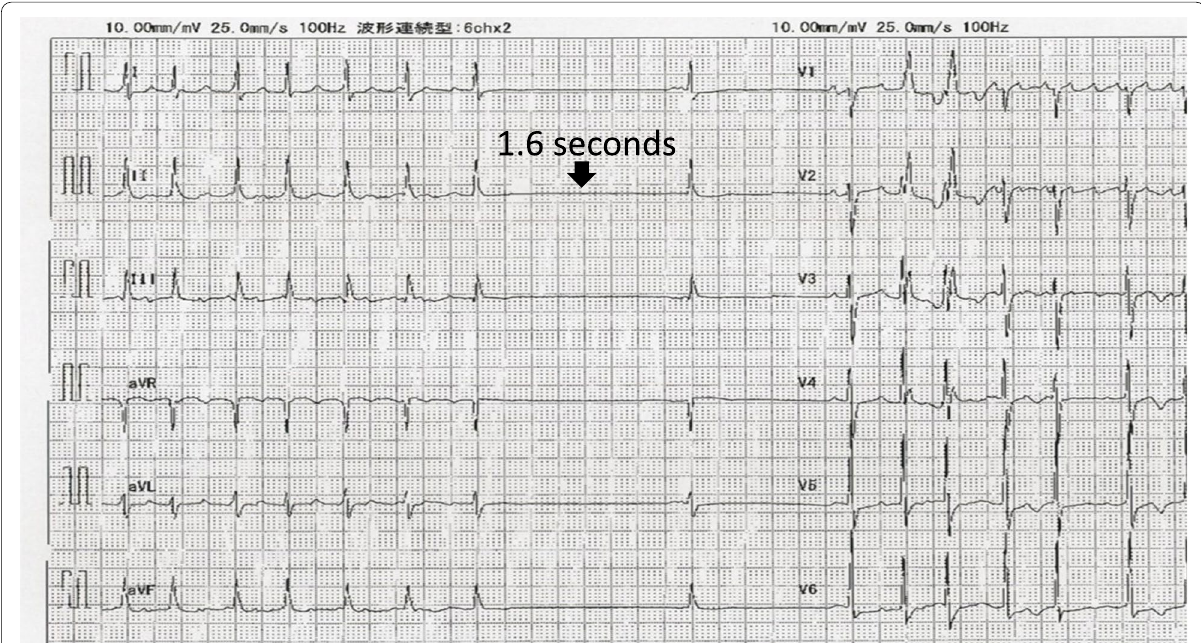
Fig. 1 Preoperative ECG during the attack. The ECG showed bradycardia-tachycardia syndrome with irregular RR intervals, atrial flutter waveform, and sinus arrest lasting about 1.6